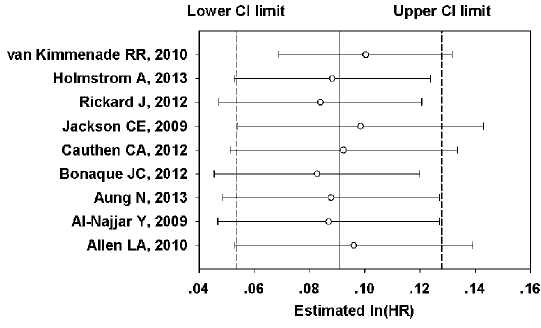
Figure 3. Sensitivity analysis for the association between RDW and ACM in HF patients. RDW, red blood cell distribution width; HF, heart failure; ACM, all-cause mortality.